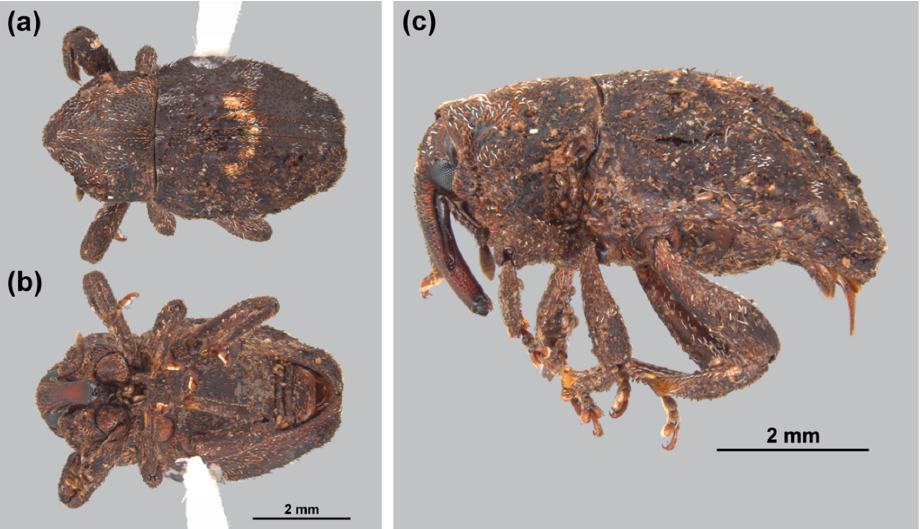
Figure 2. Habitus of Elytroteinus geophilus : ( a ) dorsal; ( b ) ventral; and ( c ) lateral views.